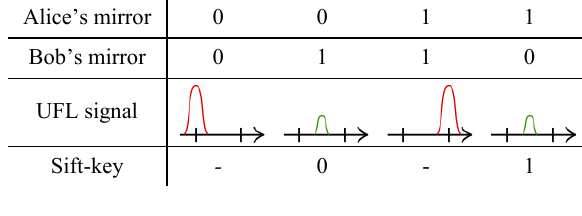
Table 1. Protocol for a key distribution system using an UFL.